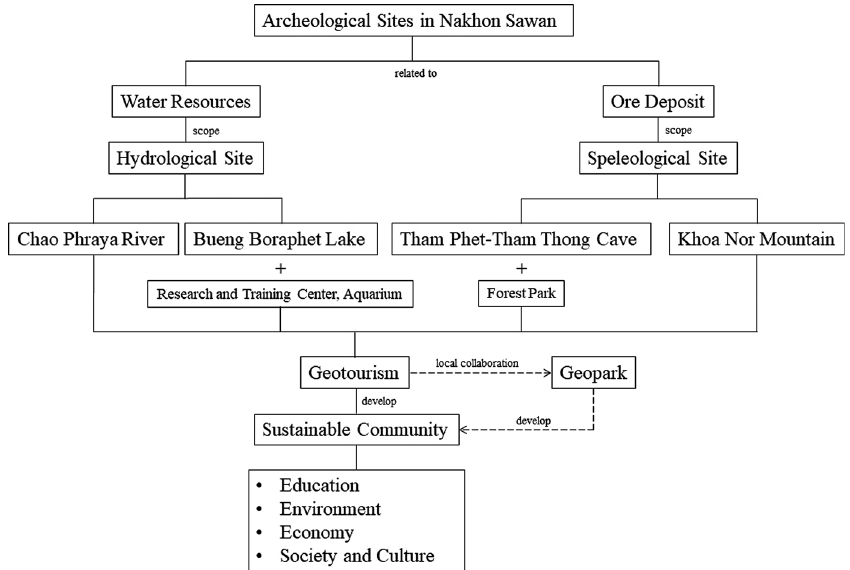
Fig. 7. The interrelationships between the archaeological sites and geology for geotourism development in Nakhon